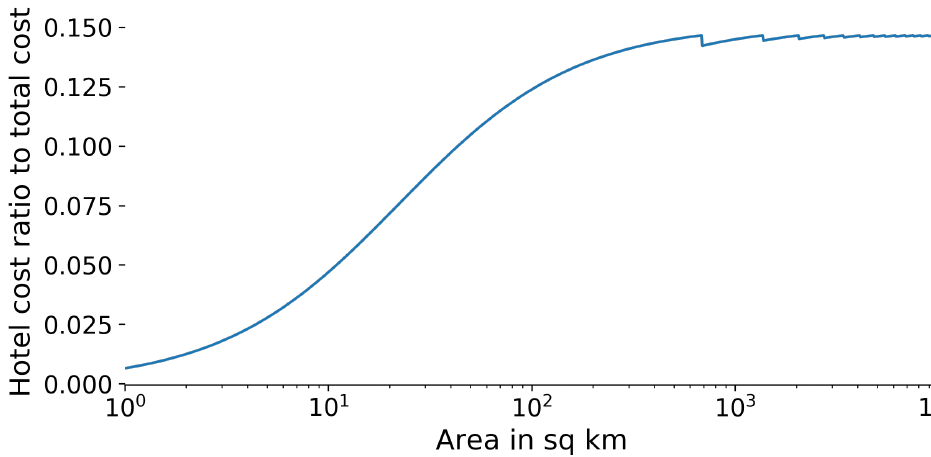
Figure A4. Hotel cost as a percentage of total cost with respect to the total area of the mission at 0.03 m